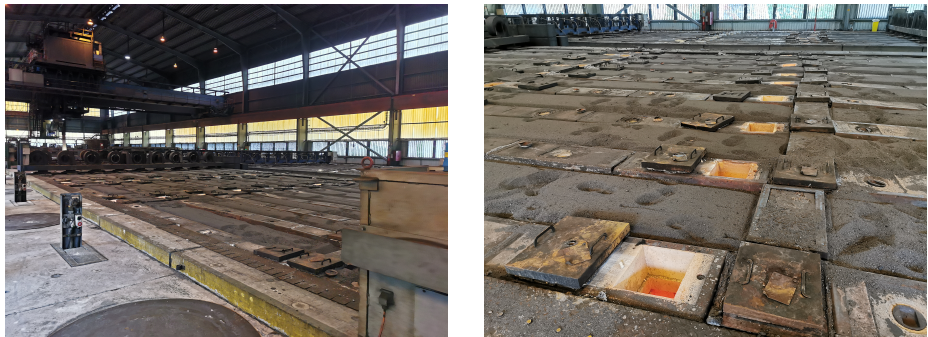
Figure 1. Views on the anode baking furnace at our industrial partner AluChemie B.V. Rotterdam.